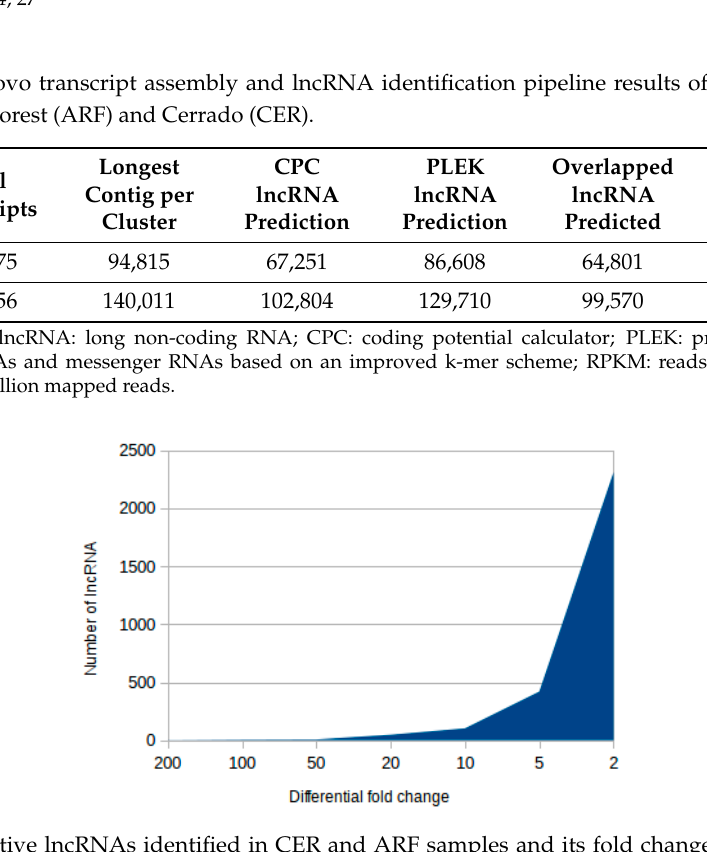
Figure 1. Putative lncRNAs identified in CER and ARF samples and its fold change regulation in comparison to each other: There were 2893 differentially regulated transcripts identified from a total of 8020 copaíba lncRNAs. The majority of the transcripts were 2 to 5 times differently expressed on either sample, yet there were 565 transcripts regulated above 5-fold on either sample.